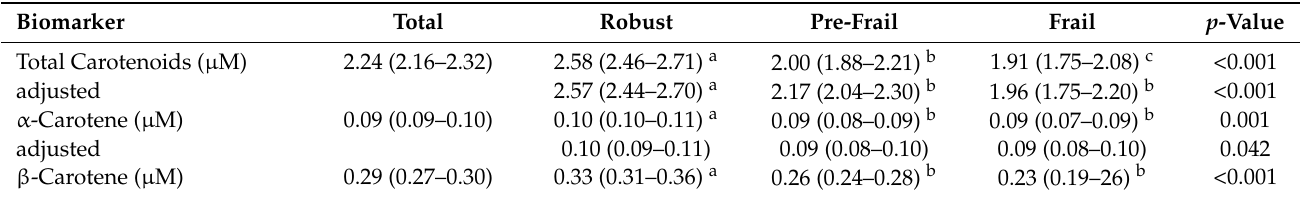
Table 2. Biomarker concentrations in dependency of frailty